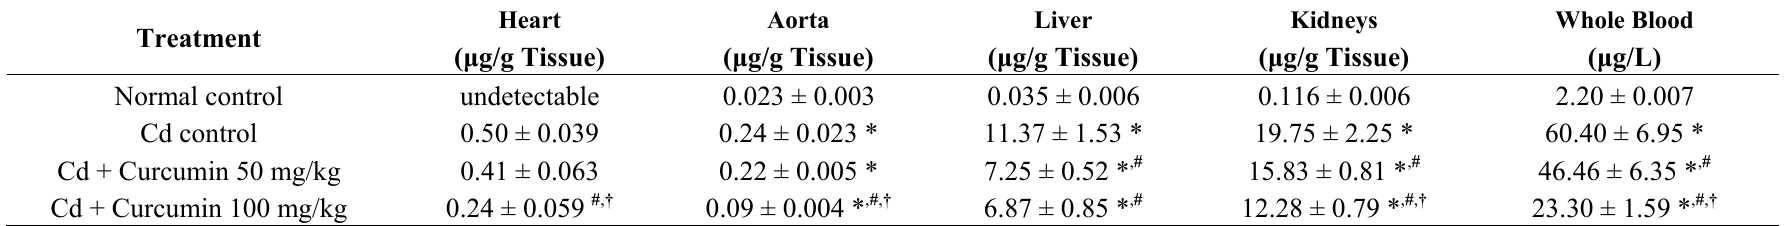
Table 3. Effects of curcumin co-administration on blood and tissue cadmium accumulation